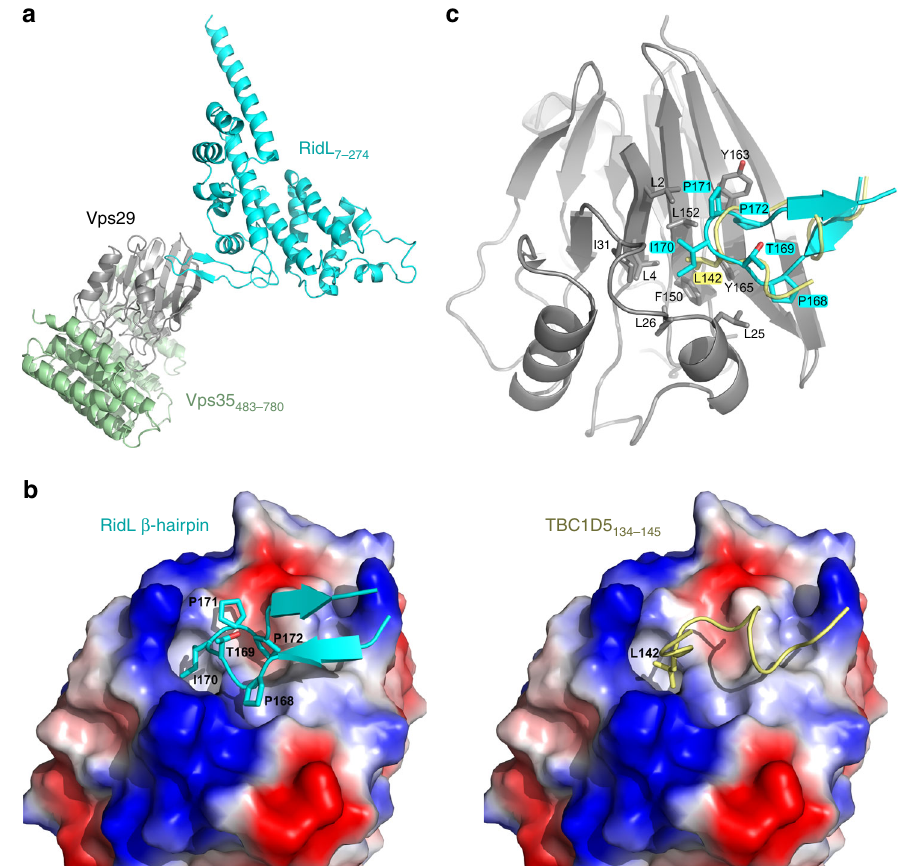
Fig. 4 Information-driven docking of RidL and Vps29. a Docking of RidL (cyan) and Vps29 (grey), in relation to the location of Vps35 (green). b The β - hairpin of RidL (cyan) extensively interacts with a hydrophobic groove at the surface of Vps29 (left). The same groove accommodates a peptide of TBC1D5 (right, PDB: 5GTU). The electrostatic potential of the Vps29 surface is shown (red and blue indicate negative and positive charge, respectively). c Close-up view of the RidL – Vps29 interaction site. Side chains lining the hydrophobic Vps29 (grey) cavity are highlighted. The β -hairpin of RidL (cyan) is shown as cartoon with sticks. As a reference, the interacting residues of TBC1D5 (yellow) are shown as cartoon and L 142 as stick representation